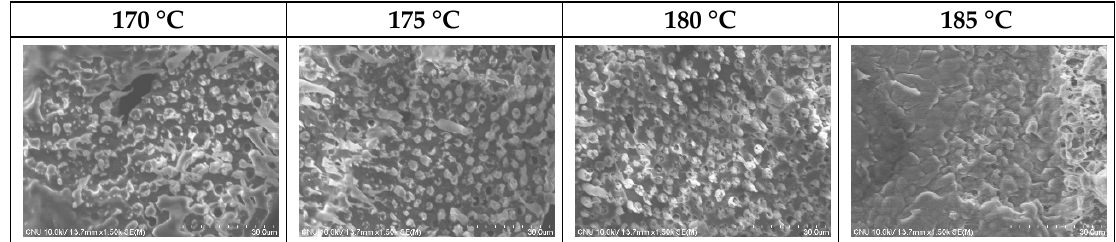
Figure 5. Cross-sectional SEM images of the PVDF/PAR composites prepared at different molding temperatures.